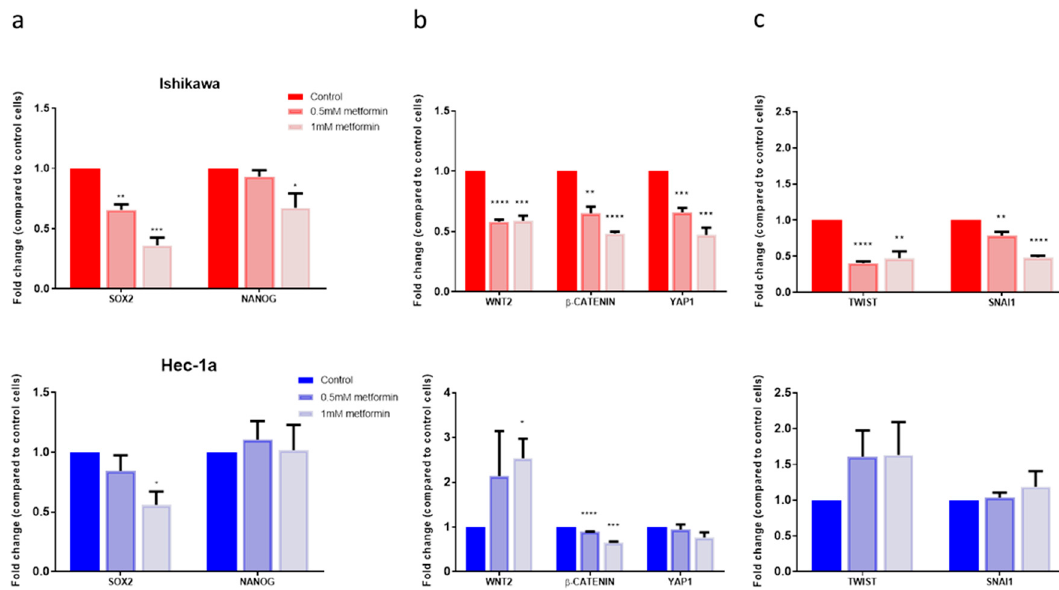
Figure 4. E ff ect of metformin on stem cell and EMT gene expression. ( a ) On the top, qRT-PCR of EMT transcription factor genes in Ishikawa cells treated with metformin. Underneath, qRT-PCR of the same genes in Hec-1a cells treated with metformin ( n = 3). ( b ) On the top, qRT-PCR of genes associated with pluripotency and self-renewal in Ishikawa cells treated with metformin. Underneath, qRT-PCR of the same genes in Hec-1a cells treated with metformin ( n = 3). ( c ) On the top, qRT-PCR of genes within the Wnt and Hippo signalling pathways in Ishikawa cells treated with metformin. Underneath, qRT-PCR of the same genes in Hec-1a cells treated with metformin ( n = 3). Data are represented as the mean ± SEM. * p ≤ 0.05, ** p ≤ 0.01, *** p ≤ 0.001, **** p ≤ 0.0001.